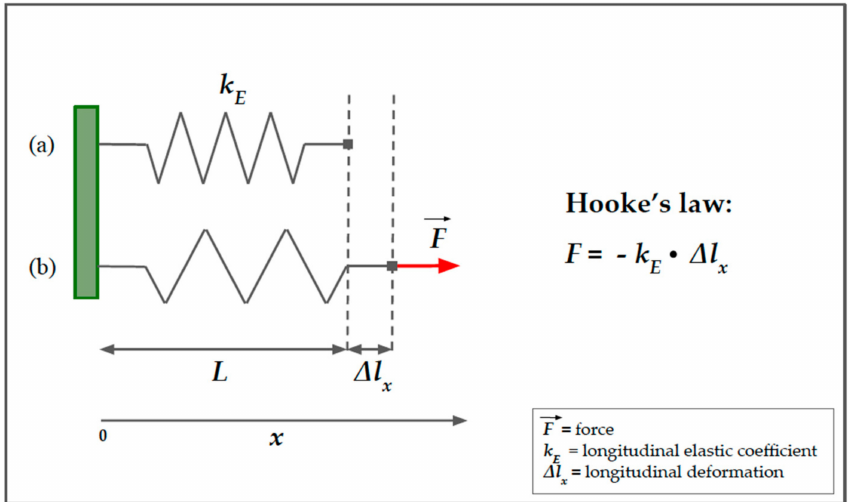
Figure 1. Spring model of Hooke’s law. A simple helical spring model can be used to represent Hooke’s law. Hooke’s law states that the force ( F ) required to extend or compress a spring for a certain distance ( ∆ l x ) scales linearly to that distance. On the left, the upper part of the image (a) represents the spring in resting conditions, characterized by a longitudinal elasticity constant, k E , that is typical of the spring. The lower part of the image (b) represents the spring in traction due to a force, F , parallel to the x -axis. ∆ l x represents the longitudinal displacement of the free hand of the spring. The minus sign in the second member of the equation means that we are considering the restoring force exerted by the spring on whatever is pulling its free end since the direction of the restoring force is opposite to that of the